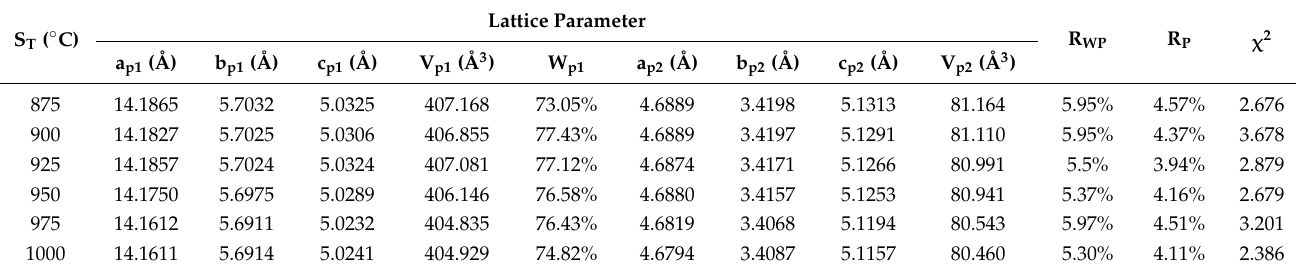
Figure 3. Rietveld refinement patterns of MgCu 2 Nb 2 O 8 ceramics sintered at several temperatures from 875 °C to 1000 °C. Raman phonon modes can be used not only to analyze the crystal structure, but also to obtain the phase composition of the ceramic system. The Raman spectra of MgCu 2 Nb 2 O 8 ceramics sintered at different temperatures are shown in Figure 4a. Twelve Raman modes, located at 220, 264, 278, 295, 314, 344, 410, 485, 533, 634, 848 and 905 cm − 1 , were detected. As for the MgNb 2 O 6 phase reported by Wu [20], the weak peak at 220 cm − 1 is attributed to the O-Nb-O bending mode. The bands at 250–400 cm − 1 are identified as the twisting vibration of octahedron. The modes located at 410, 485, 533, 848 and 905 cm − 1 are assigned as the stretching vibration of Nb-O bonds. For CuO, three Raman active optical phonons (Ag +2Bg) could be observed clearly from the Raman spectra. The peaks of 295, 344 and 634 cm − 1 are correspondent to the Ag, Bg and Bg modes, respectively, and it is consistent with the previous results [21]. Thus, Raman analysis also proves that MgCu 2 Nb 2 O 8 ceramics are composed of MgNb 2 O 6 and CuO. In addition, Raman phonon modes are sensitive to not only the crystal structures but also to dielectric properties of the ceramics. As presented in Figure 4b for the A g (MgNb 2 O 6 or CuO) modes, the full width at half-maximum (FWHM) displays an opposite changing trend as that in Q × f value. As reported by Liu [22], FWHM value is closely related to the damping coefficient, which had a great influence on the dielectric losses. Generally, a weaker FWHM value usually corre- sponded to a higher Q × f value. Notably, the sample sintered at 925 °C possessed the